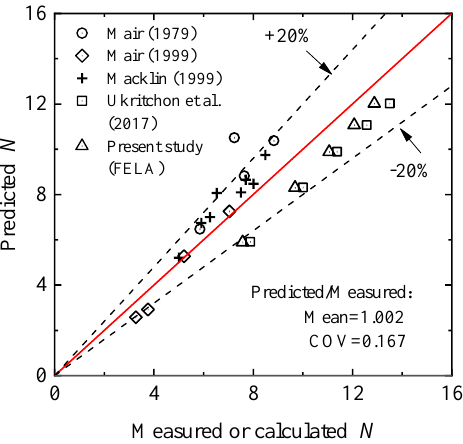
Figure 8. Measured versus predicted stability number for 0 ≤ L / D < 0.5.